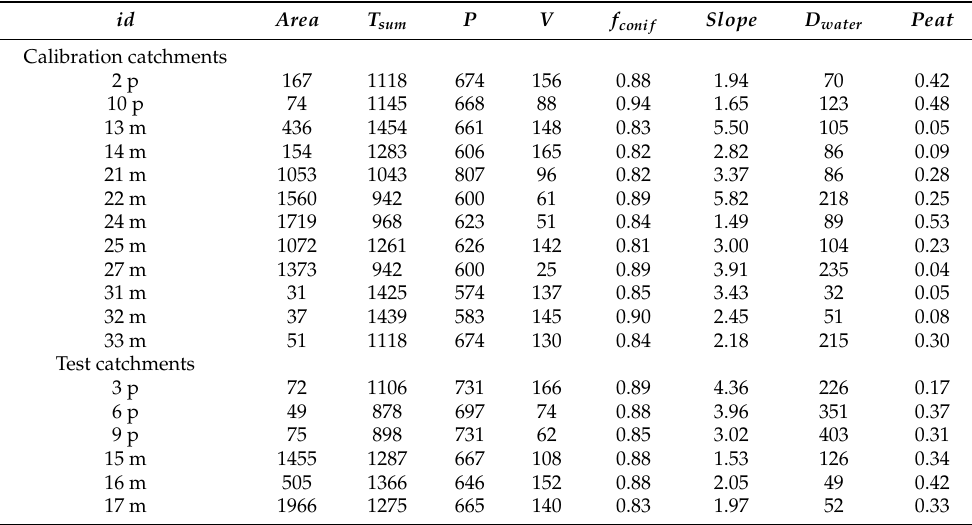
Table 1. Characteristics of calibration and test catchments: id denotes catchment identification number, p is pristine and m is managed catchment, Area is catchment area in ha, T sum is temperature sum in degree days, P r is mean annual precipitation in mm, V is the mean stand volume in m 3 ha − 1 , f conif is the fraction of coniferous trees from the total stand volume in the catchment, Slope is the mean slope in the catchment in %, D water is the mean distance to water body in m, and Peat is the share of peatland sites from total area of the catchment. id Area T sum